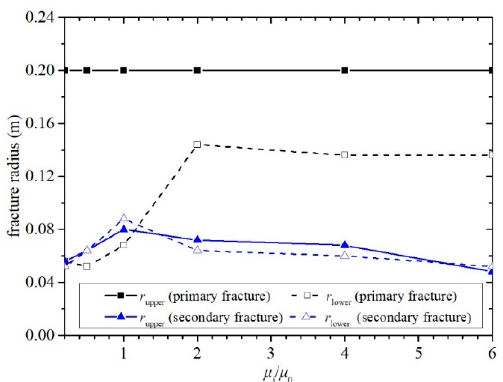
Figure 19. The seepage fields (MPa) of models with different hydraulic fluid viscosity when the primary fractures reach the boundary: ( a ) Multi-vis1, t = 1160 s, μ 1 / μ 0 = 0.2; ( b ) Multi-vis2, t = 1650 s, μ 2 / μ 0 = 0.5; ( c ) Multi-01, t = 2120 s, μ 0 / μ 0 = 1.0; ( d ) Multi-vis3, t = 2322 s, μ 3 / μ 0 = 2.0; ( e ) Multi-vis4, t =